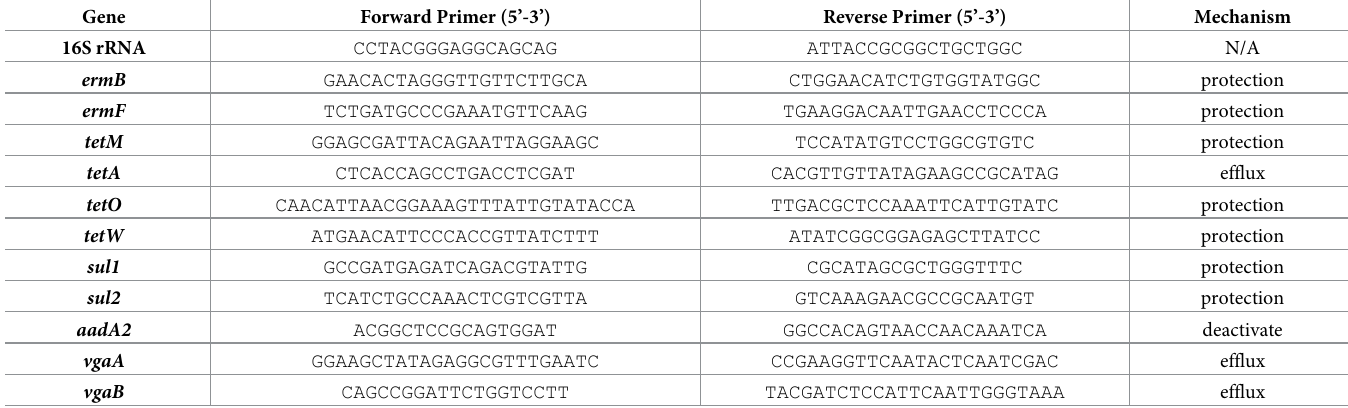
Table 1. List of primers used in the study